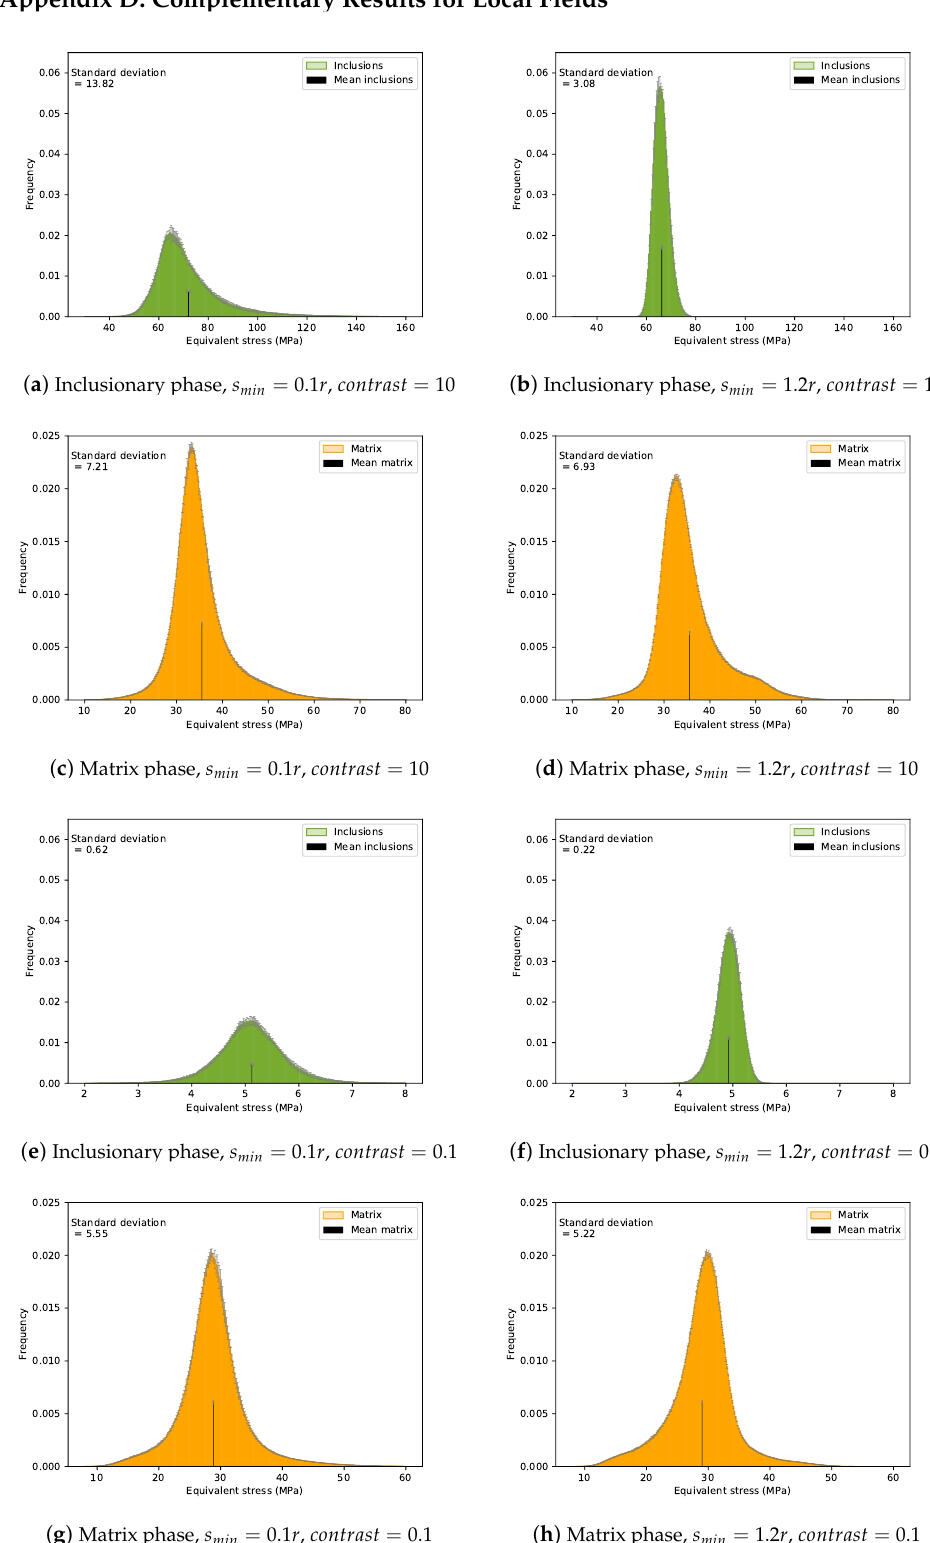
Figure A9. Frequency histograms of equivalent stress by phase at SR = 10, f v = 13.4 %, and the extreme s min values ( s min = 0.1 r and s min = 1.2 r ) for contrasts of 10 and